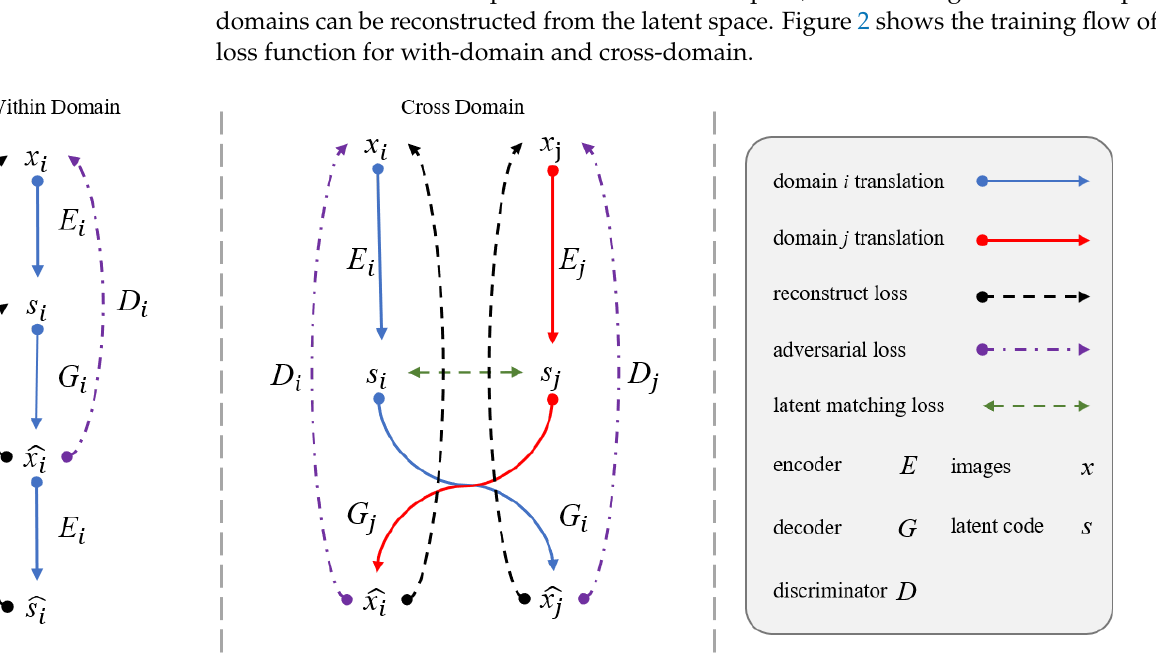
Figure 2. The within-domain and cross-domain training flowchart.